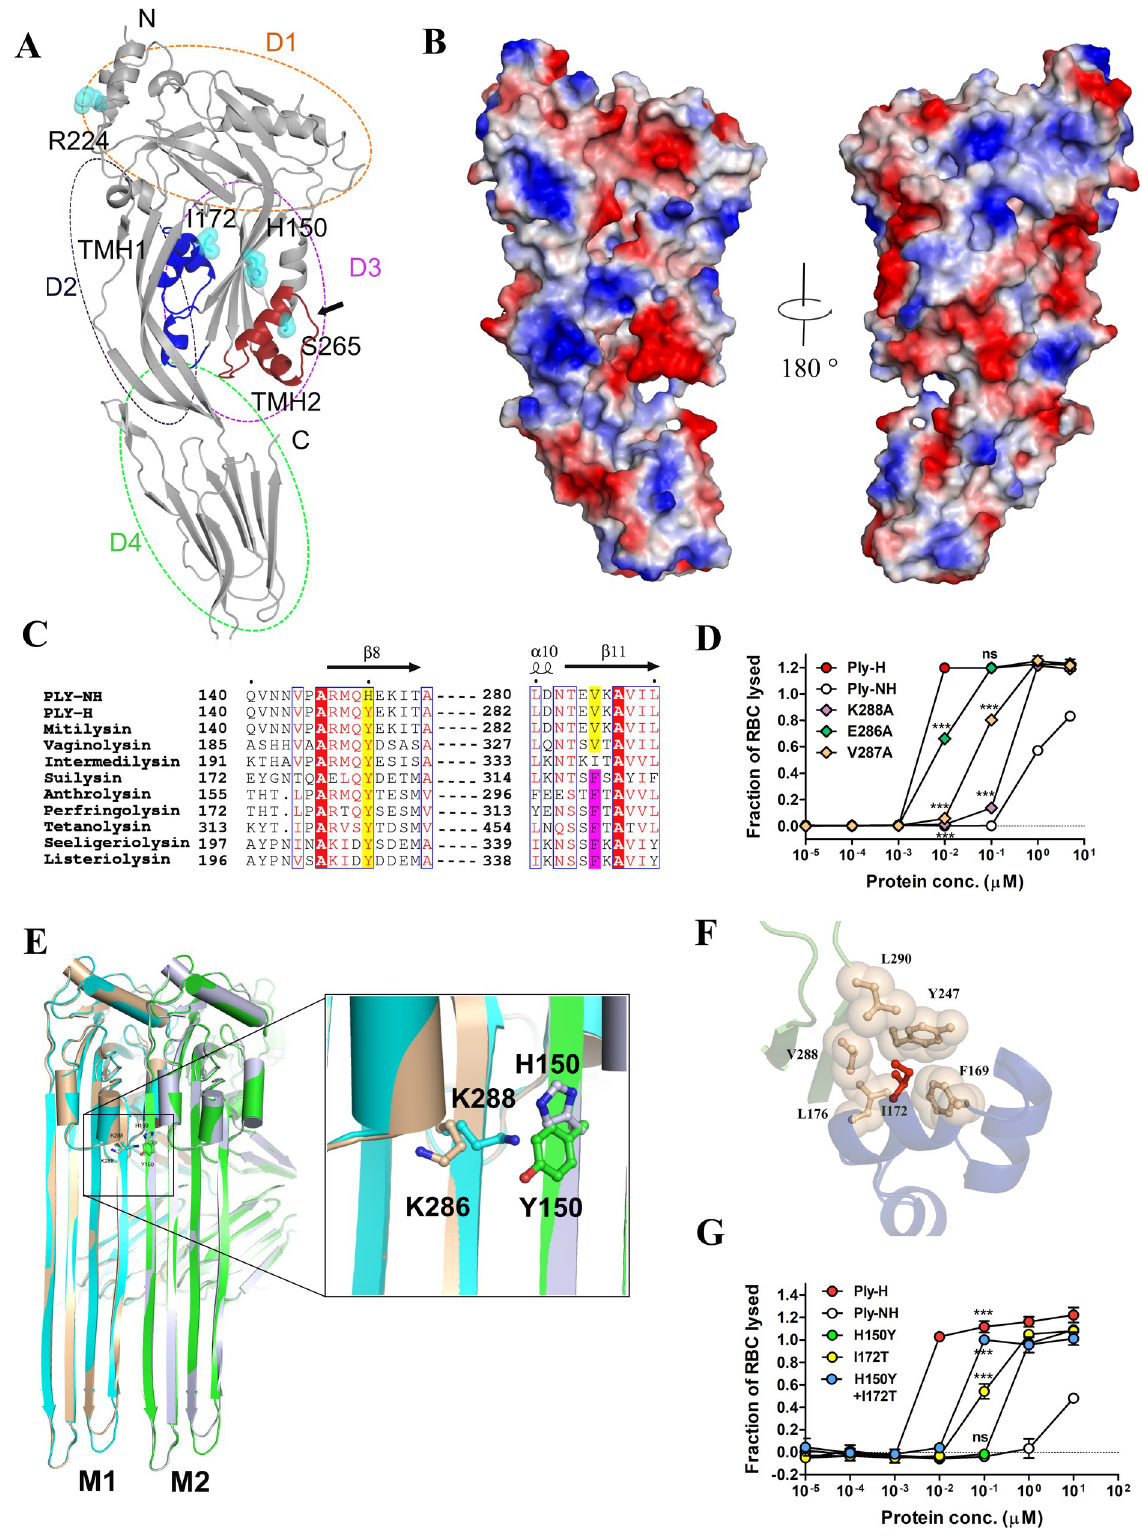
Fig 2. Loss of an essential cation- π interaction inhibits transmembrane β -hairpin (TMH) formation in Ply-NH. ( A ) Cartoon representation of Ply-NH crystal structure where individual domains are labelled as D1, D2, D3 and D4. The substitutions are represented as spheres along with ball and stick and colored according to elements (C-cyan, N-blue and O-red). The deletion is marked by black arrow. The TMH1 and TMH2 are also highlighted in blue and brown, respectively. ( B ) Electrostatic surface representation of Ply-NH. The blue and red indicate the electropositive and electronegative regions, respectively. ( C ) Multiple sequence alignment of CDCs highlighting the conservation PLOS Pathogens| https://doi.org/10.1371/journal.ppat.1009016 November 20,